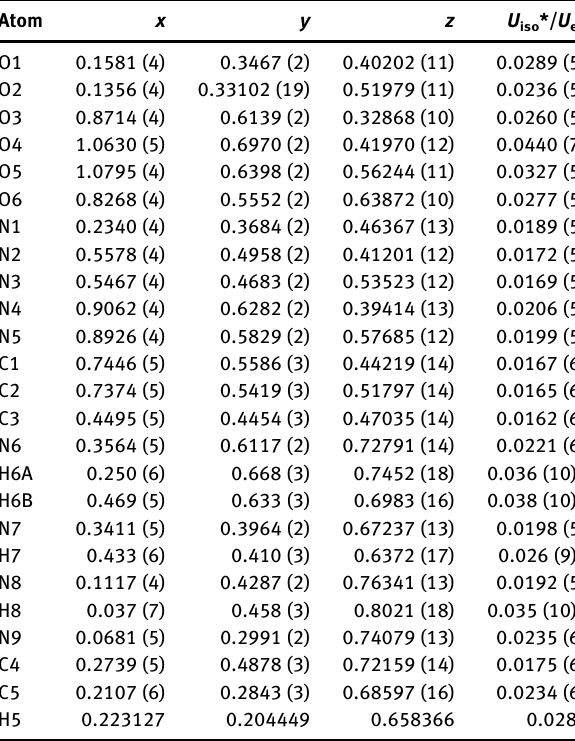
2,4,5-trinitroimidazole anion and the 3-amino-1,2,4-triazole cation. The bond lengths and angles within these moieties are in the expected ranges. The imidazole ring and 1,2,4-triazole ring are planar. The oxygen atoms of nitro groups and the hydrogen atoms of amino group are twisted out the imidazole ring and 1,2,4-triazole ring, respectively.